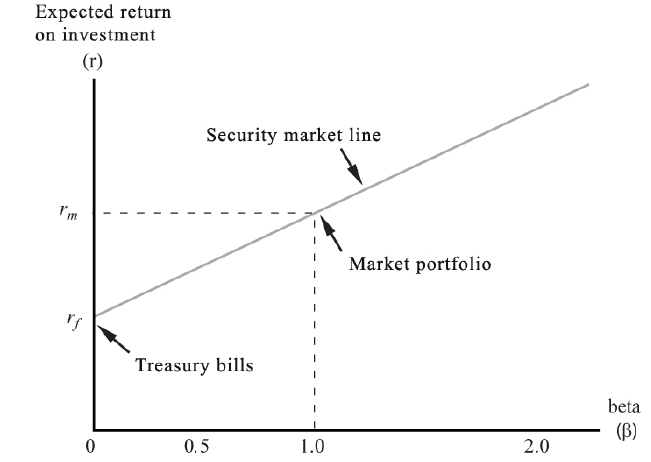
Figure 1. Plot of the expected return treasury bills and the market portfolio. Source: